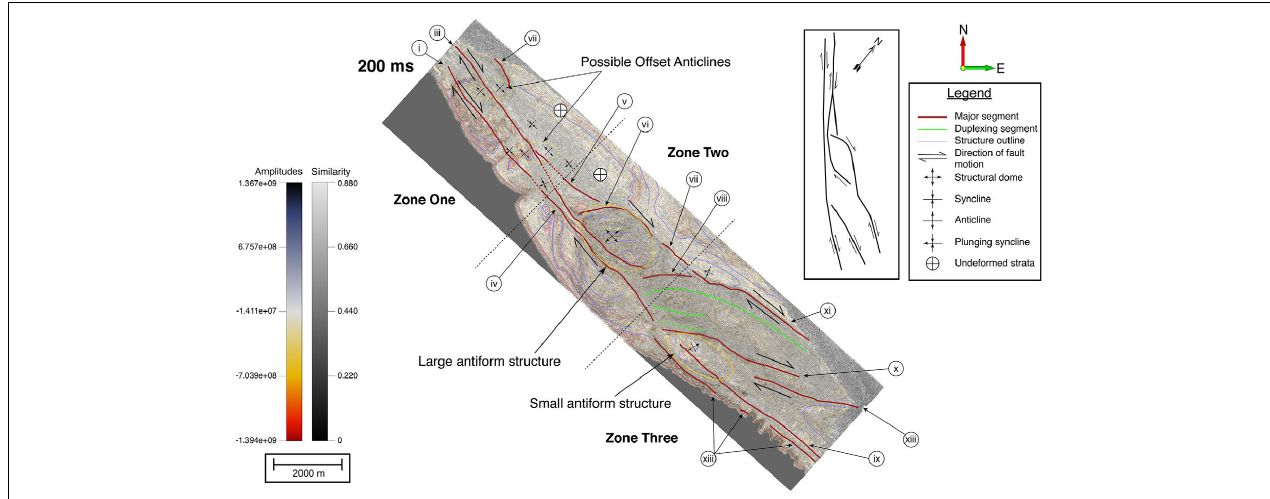
FIGURE 13 | Map view of time-slice 200 ms ( ∼ 156 m) showing major fault interpretations and right-lateral movement. Time-slice is a combination of amplitude data, overlapped with similarity attribute data at 60% transparency. The survey area is divided into three zones based on fault character and acoustic facies. Solid yellow ovals outline area of large and small anticlines in Zones Two and Three. In Zone One an alternating sequence of anticlines and synclines is imaged. Dashed yellow ovals group possible offset anticlines. Green lines denote possible duplex faulting. Light purple lines outline structures and patterns in the amplitude data. Inset shows a simplified kinematic diagram of the major faults in the survey